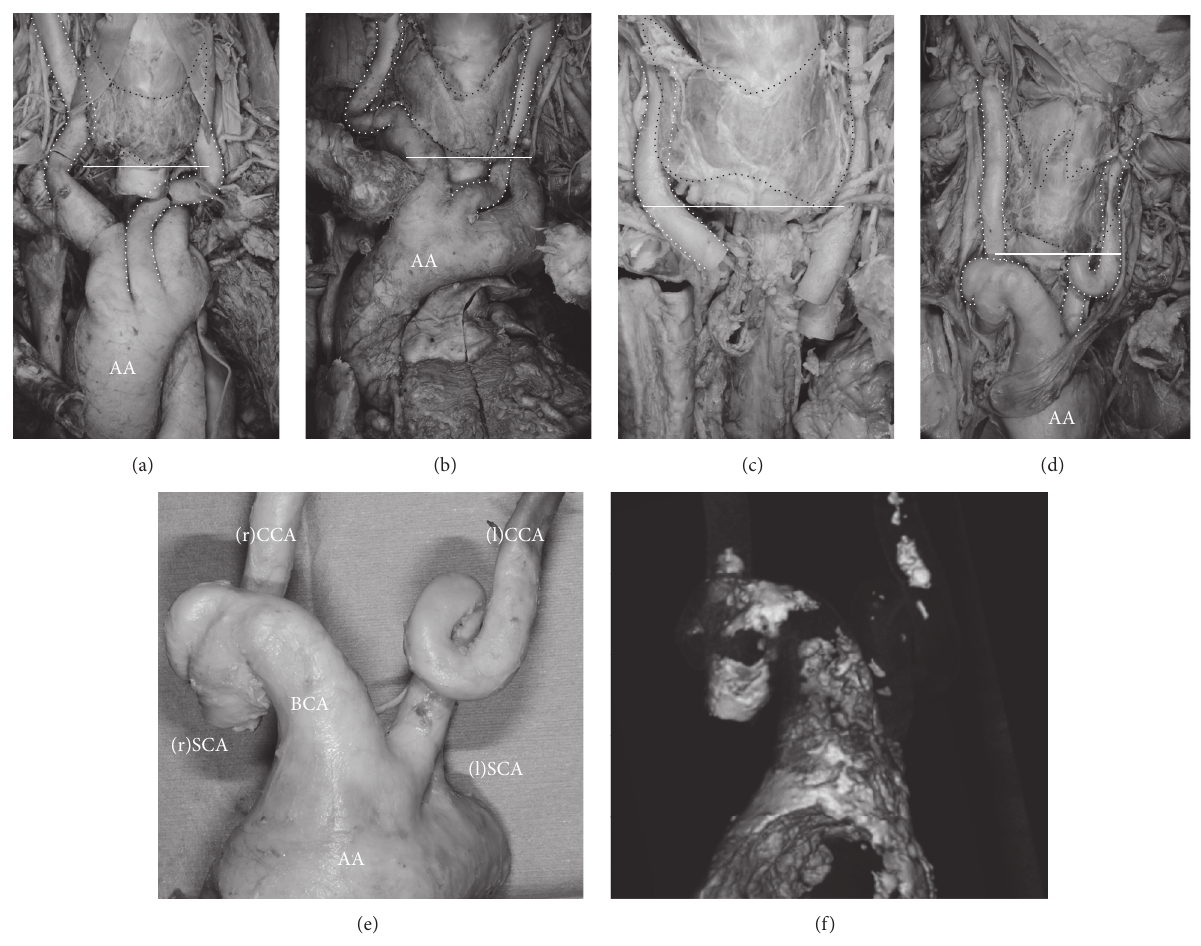
Figure 1: Four cases of tortuous common carotid artery (CCA) reported in the present study. Black dotted lines indicate the thyroid glands. White dotted lines indicate the common carotid arteries. White lines show the inferior border of the thyroid glands. (a) Case 1 . Bilateral tortuous CCAs ascend posterior to the thyroid gland. The left side is especially tortuous. (b) Case 2 . Bilateral tortuous CCAs ascend posterior to the thyroid gland. The right side is especially tortuous. (c) Case 3 . Tortuous CCA on the right side ascends posterior to the thyroid gland. The aortic arch had been removed during dissection. (d) Case 4 . Bilateral tortuous CCAs ascend posterior to the thyroid gland with a 360 ∘ turn. The brachiocephalic trunk is also tortuous and hypertrophied. (e) Case 4 . Aortic arch and its branches after removal from the body. The vascular wall is highly calcified and has lost its elasticity. (f) Case 4 . Computed tomography (CT) image shows the calcified part of the aortic arch and its branches. White parts, which had high CT values, are suspected to be calcified. AA: aortic arch; BCA: brachiocephalic artery; CCA: common carotid artery; SCA: subclavian